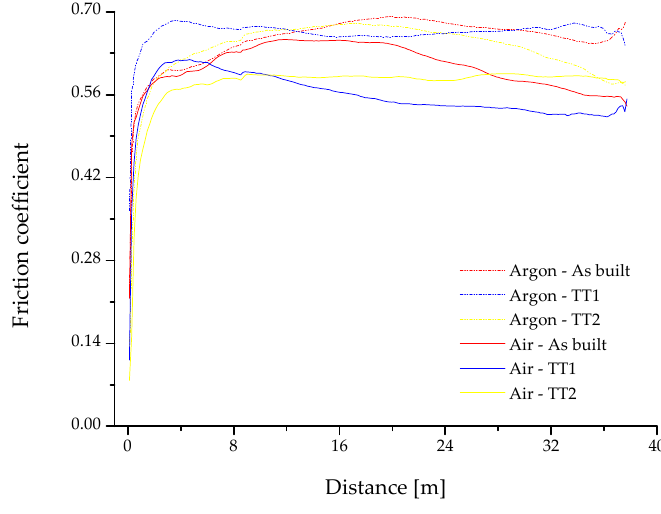
Figure 15. Friction coefficient vs. distance (m).